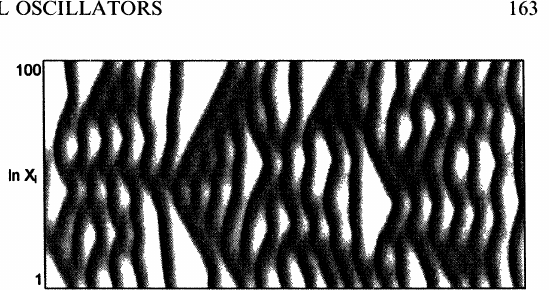
FIGURE 2 Spatio-temporal evolution of 100 oscillators Eq. (2) coupled in the form of Eq. (3) with a 1, b--3, d= 1, Dx Dy 5. Logarithms of the concentrations of variables Xi were grey coded from -4 (white) to 2 (black). trast, we now couple five cells of the oscillator in Eq. (2) in the oscillatory parameter domain with equal diffusion coefficients, i.e. a ratio Dx/Dy 1. For a coupling strength of Dx D 0.05 we